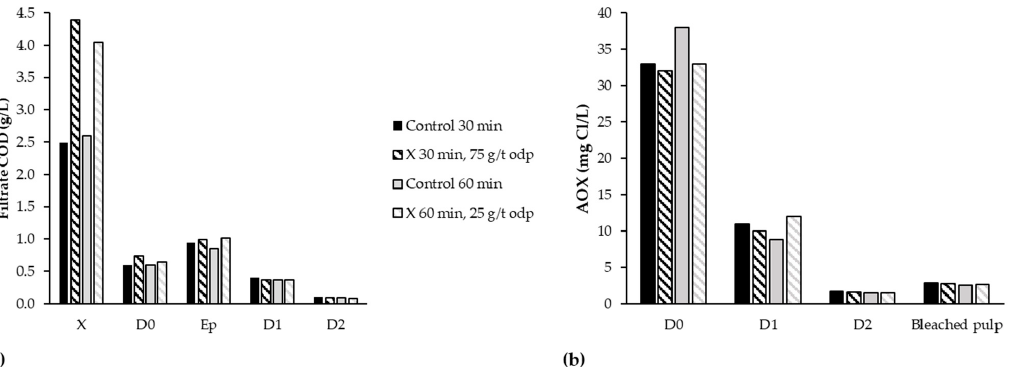
Figure 5. COD ( a ) and AOX ( b ) values observed in the filtrates from bleaching of enzyme-treated and untreated oxygen-delignified eucalypt kraft pulp. AOX was also determined in fully bleached